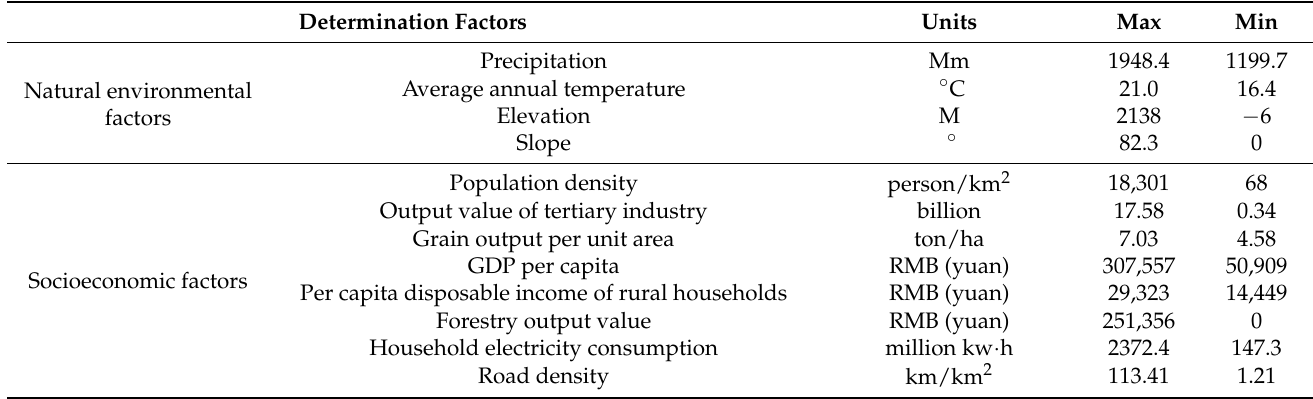
Table 1. Determination factors of the spatial distribution of forest